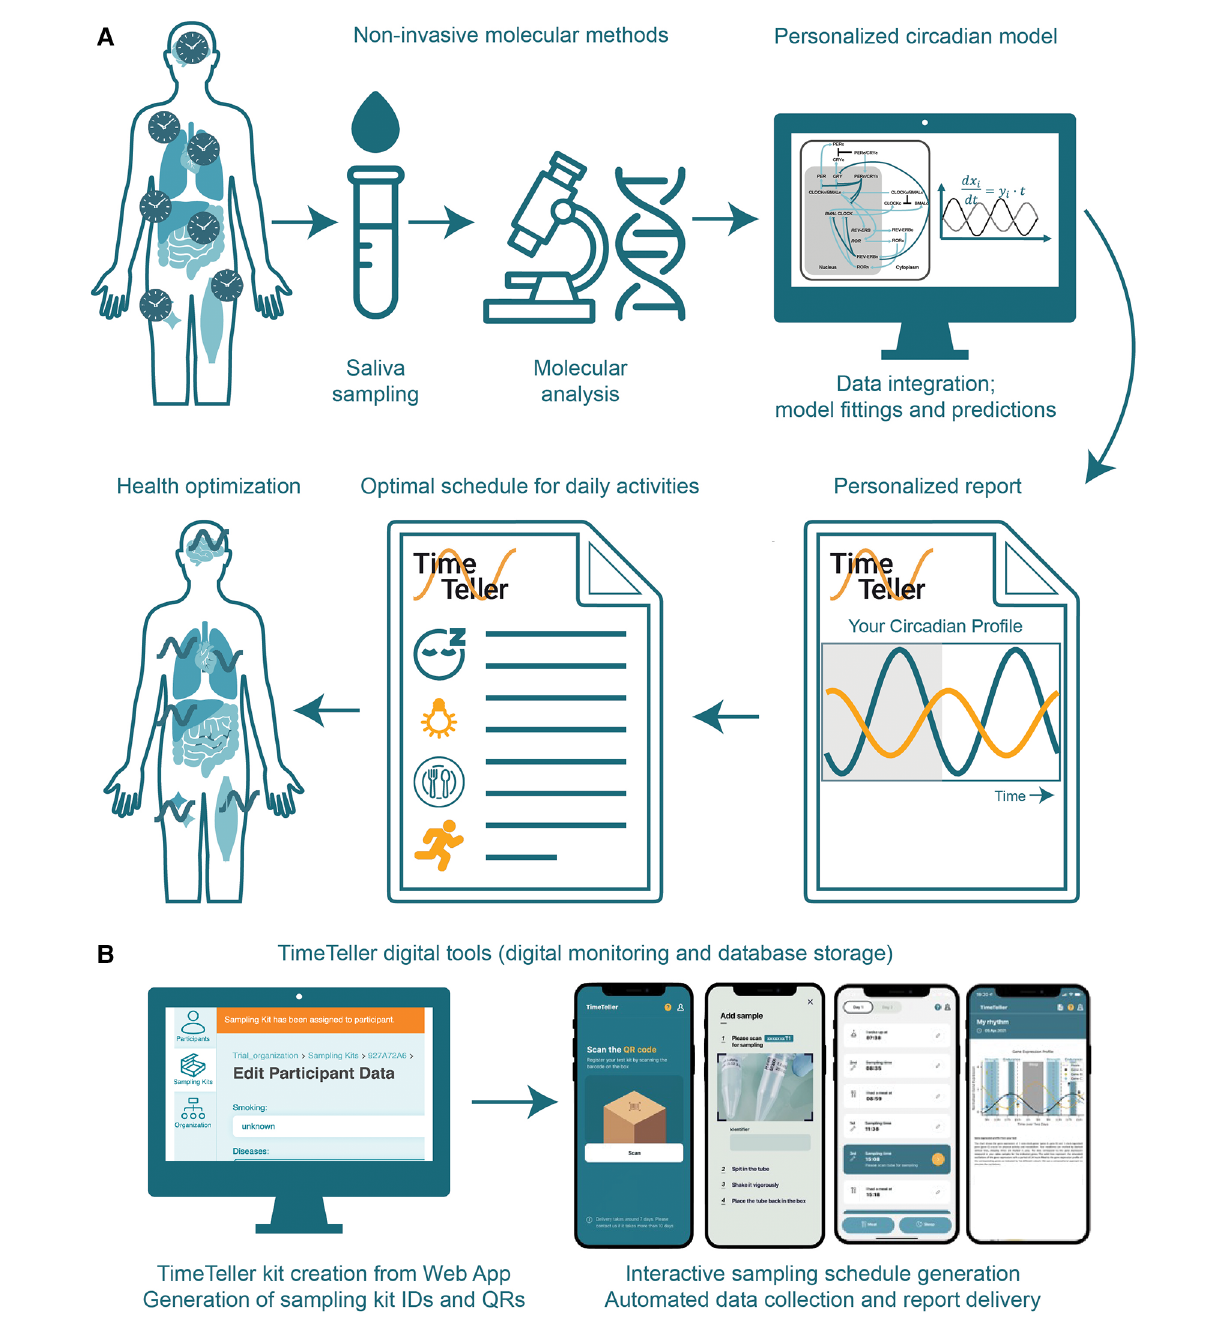
FIGURE 2 TimeTeller: a non-invasive method for pro fi ling the CR and prediction of optimal times for daily activities. ( A ) TimeTeller pipeline for saliva collection at de fi ned times, molecular and computational analysis and report generation with circadian pro fi le and recommendations to optimize health. ( B ) Digital tools to manage sampling logistics (left) and digital patient support to increase compliance